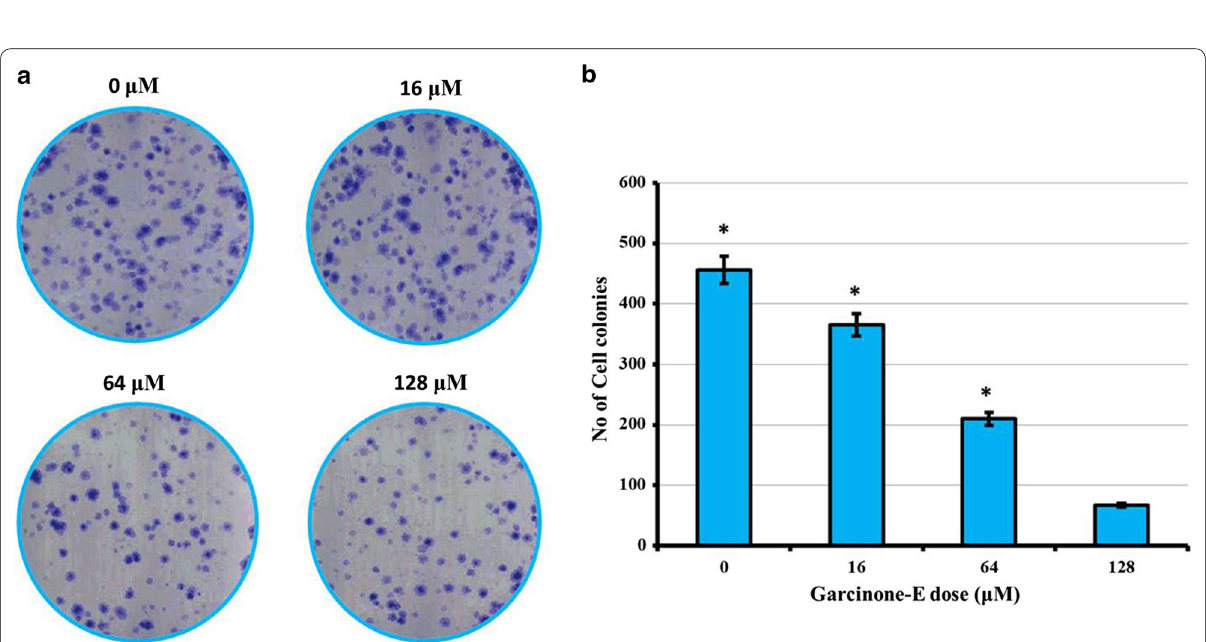
Fig. 4 Clonogenic studies of HeLa cells after being subjected to garcinone-E exposure for 12 days. Individual separate experiments were implemented three times considering p < 0.05 as statistically significant and data was signified as